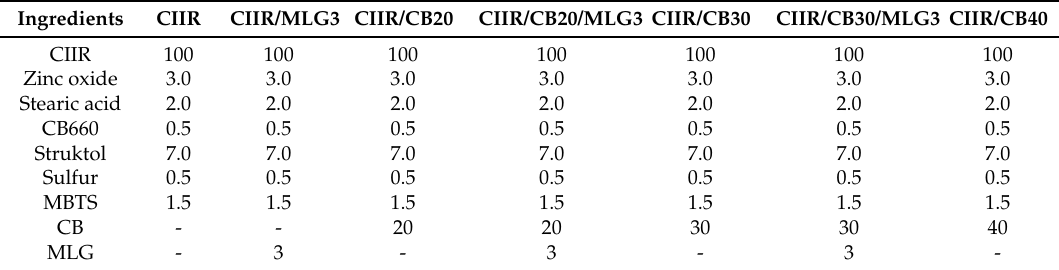
Table 1. Formulation of the CIIR (chlorine isobutyl isoprene rubber) compounds in parts per hundred of rubber